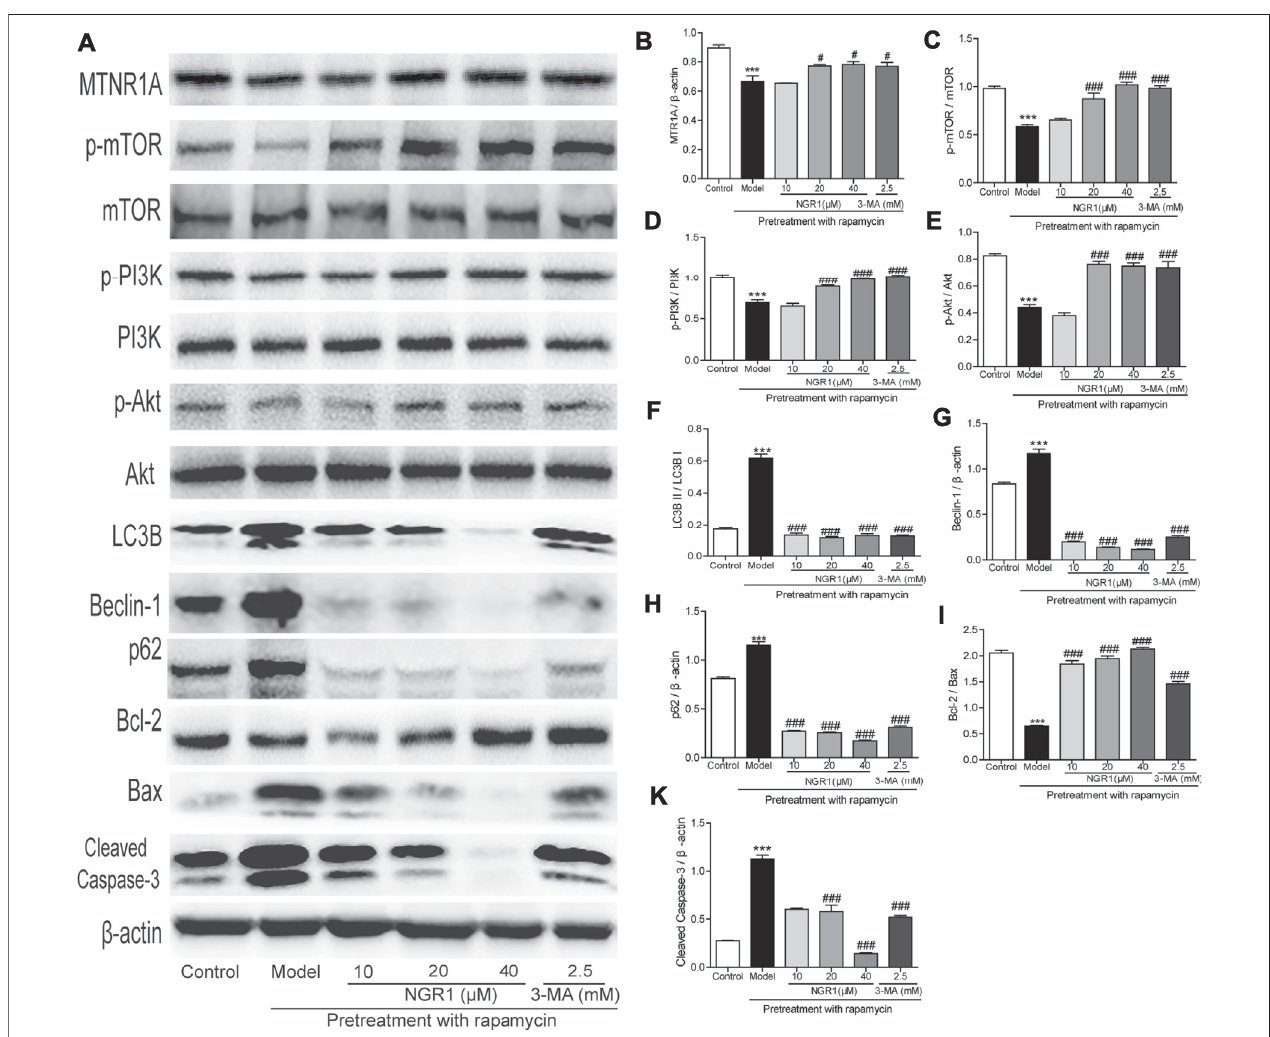
FIGURE5| NGR1regulatedtheexpressionsofproteinsinvolvedinautophagyandapoptosisinHT-22cellsinducedbyrapamycin. (A) Proteinbands. (B) – (K) Gray intensity analysis of the protein bands. n (cid:1) 5/group. *** p < 0.001 vs. control group. # p < 0.05, ### p < 0.001 vs. model group. (NGR1: notoginsenoside R1; MTNR1A: melatonin receptors 1A; 3-MA, 3-methyladenine; mTOR, mammalian target of rapamycin; p62, ubiquitin-binding protein p62 or sequestosome-1; p-Akt, phosphorylated PKB; p-PI3K, phosphorylated PI3K).